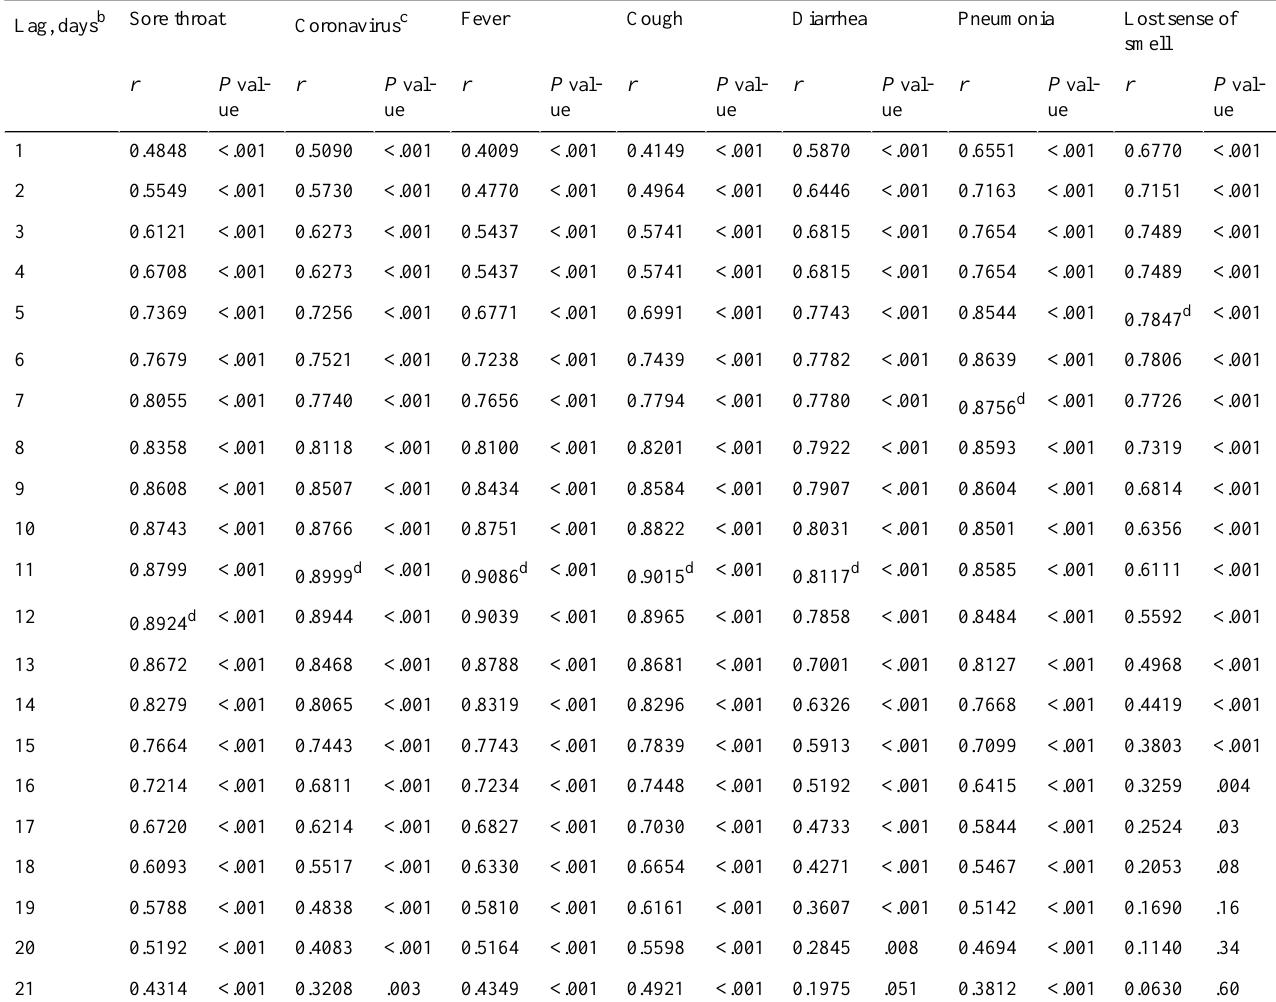
Table 2. Pearson correlation coefficients and P values for each of the symptom-related search terms, excluding fatigue. Time lags with respect to COVID-19 incidence data are also presented a